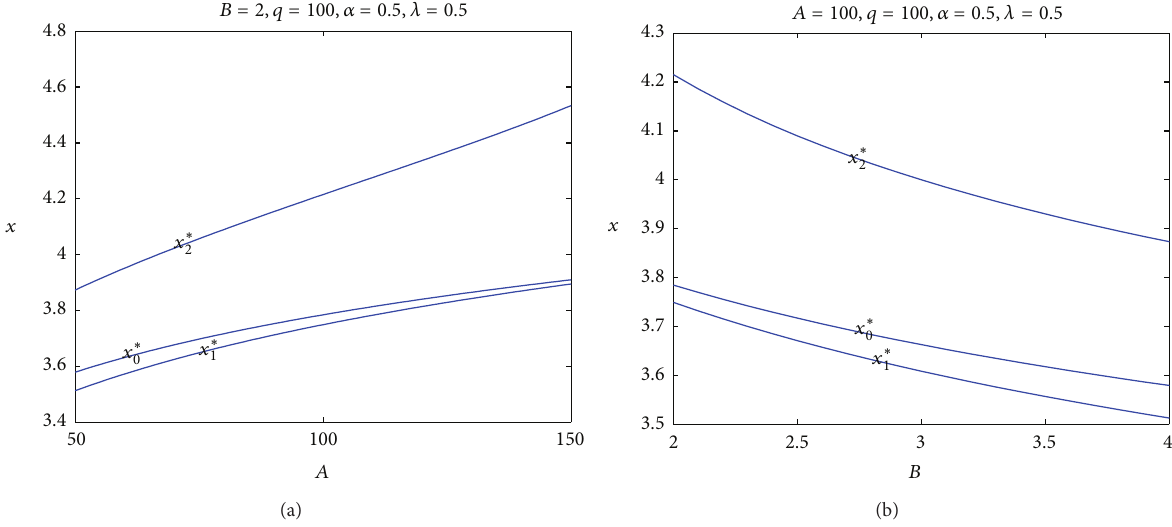
Figure 1: Optimal wholesale prices 𝑥 ∗ 0 , 𝑥 ∗ 1 , and 𝑥 ∗ 2 for different shortage penalty coefficient 𝐴 and excess penalty coefficient 𝐵 .